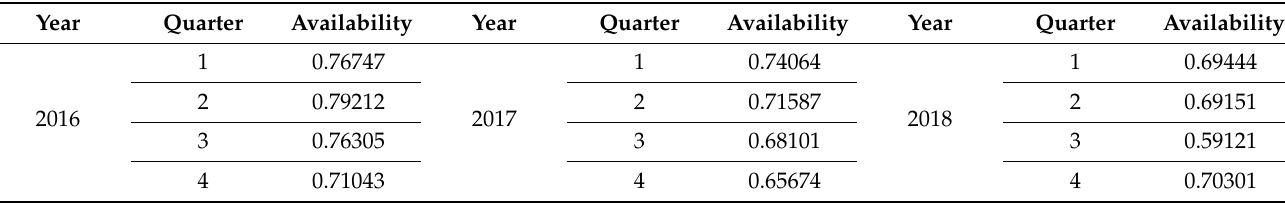
Table 3. Obtained values for the system